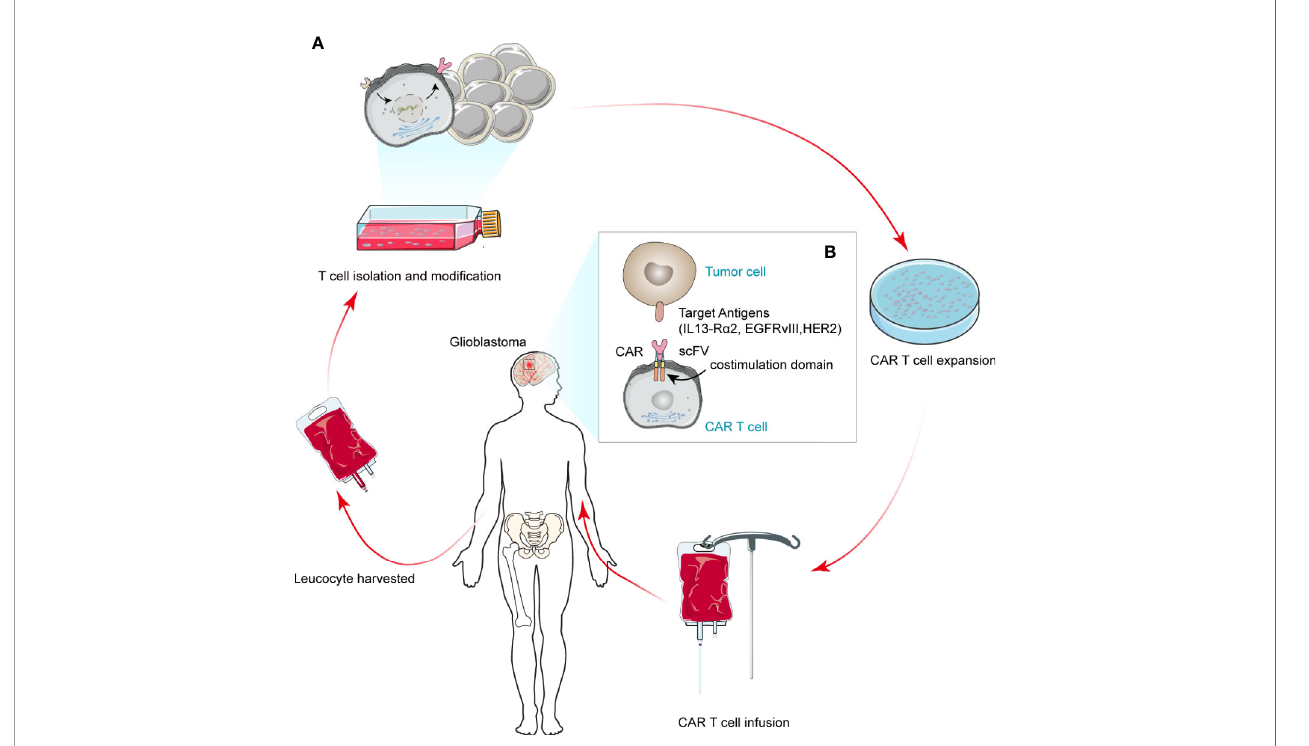
FIGURE 1 | Schematic depicting regulatory CAR T therapy in GBM. A modi fi ed CAR T cell can recognize tumor cell surface antigens in an MHC-independent manner, thus inducing tumor cell death. Currently, the antigens available for clinical trials for GBM tumor cells are IL13-R a 2, HER2, and EGFRvIII. The scFv represents a single variable region of antibody expression in T